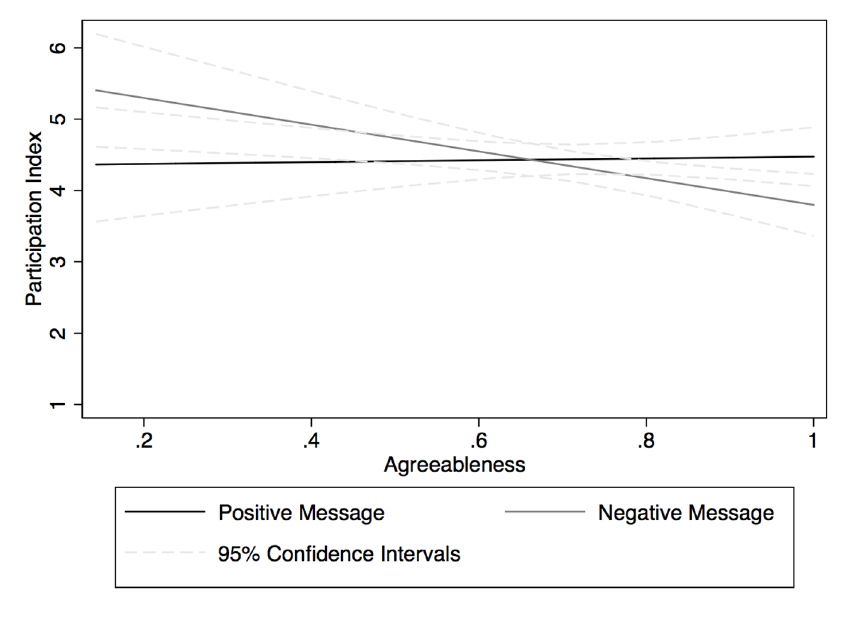
Figure 1. Interaction between agreeableness and negative political message. Note. Other variables in model set at median